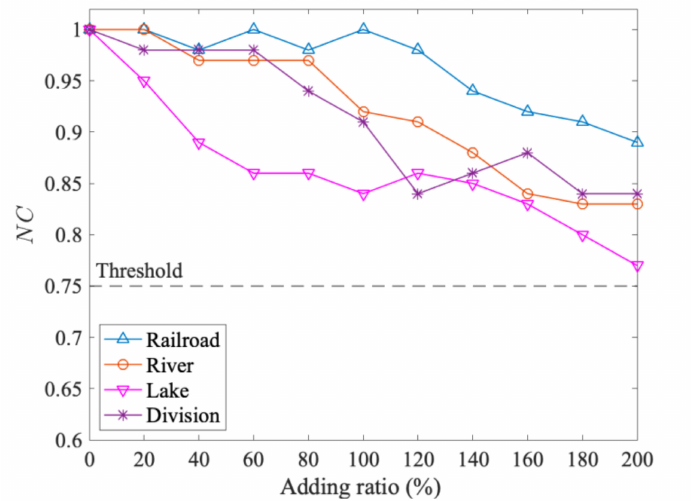
Figure 14. The results after adding objects.